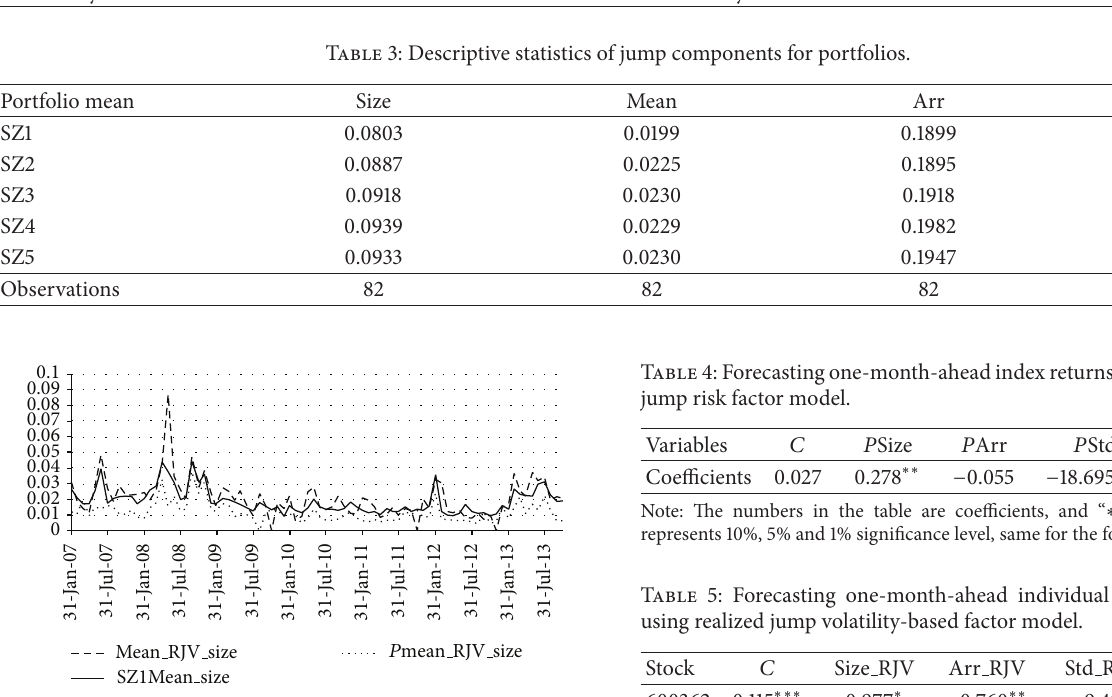
Figure 4: Jump size mean for a stock, a size 1 portfolio, and an A- share index.